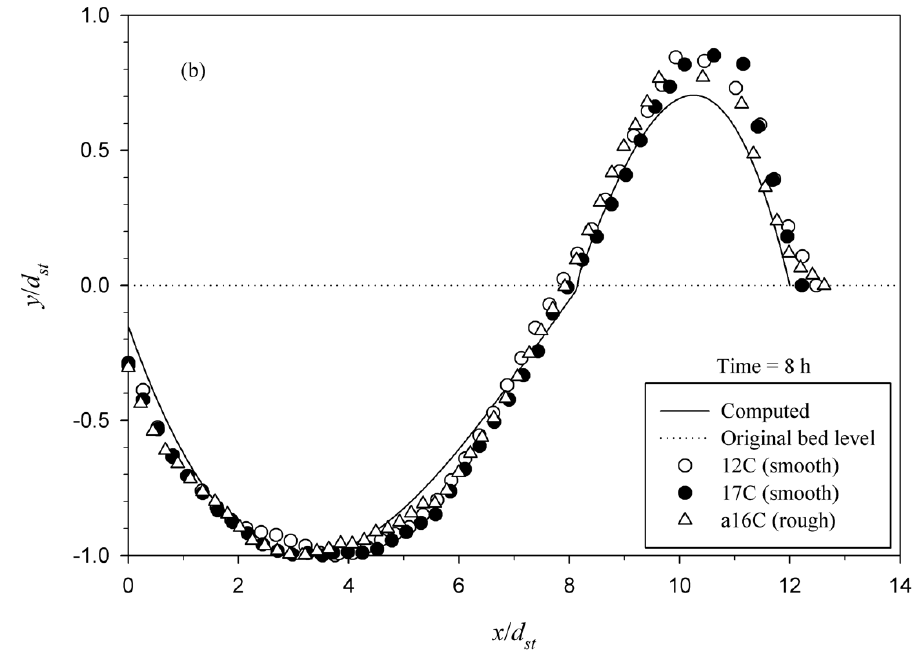
Figure 12. Non-dimensional scour profiles for different runs at ( a ) t = 1 h and ( b ) t = 8 h.